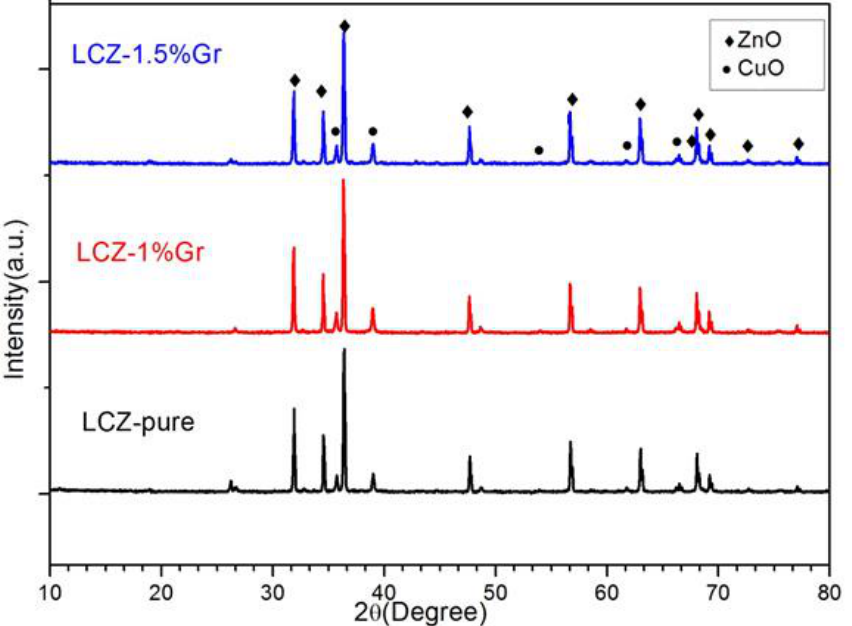
Figure 1. XRD pattern for LCZ-pure and graphene incorporated materials sintered at 800 °C for four hours.